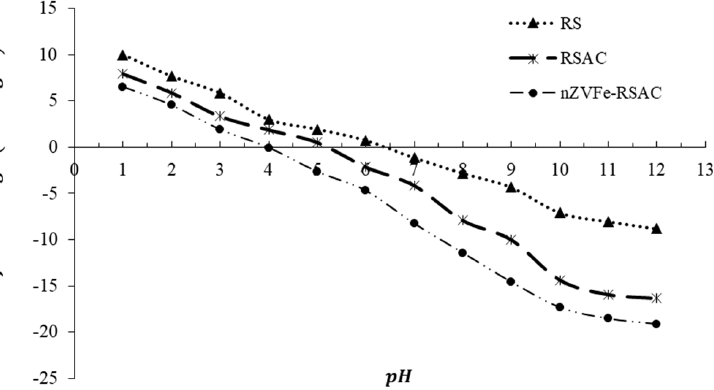
Figure 5. Zeta potential of the RS, RSAC, and nZVFe–RSAC as a function of pH.